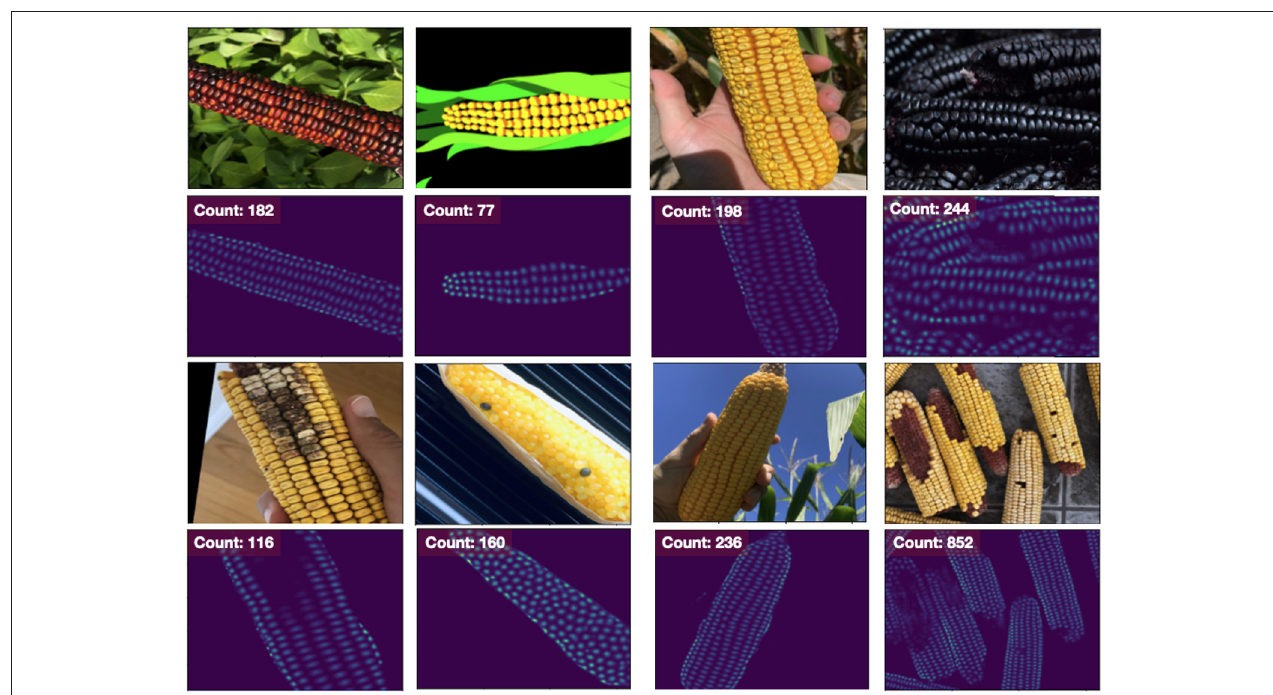
FIGURE 4 | Results from our Density Estimation approach using an EfficientNet-b1 model. Other models are visually similar. Even though it was trained on the base dataset (left two columns), it performs quite well on the narrow (third column) and many (far right) dataset as well. Even though the number of instances may be large, the model does not struggle with memory issues and continues to be computationally